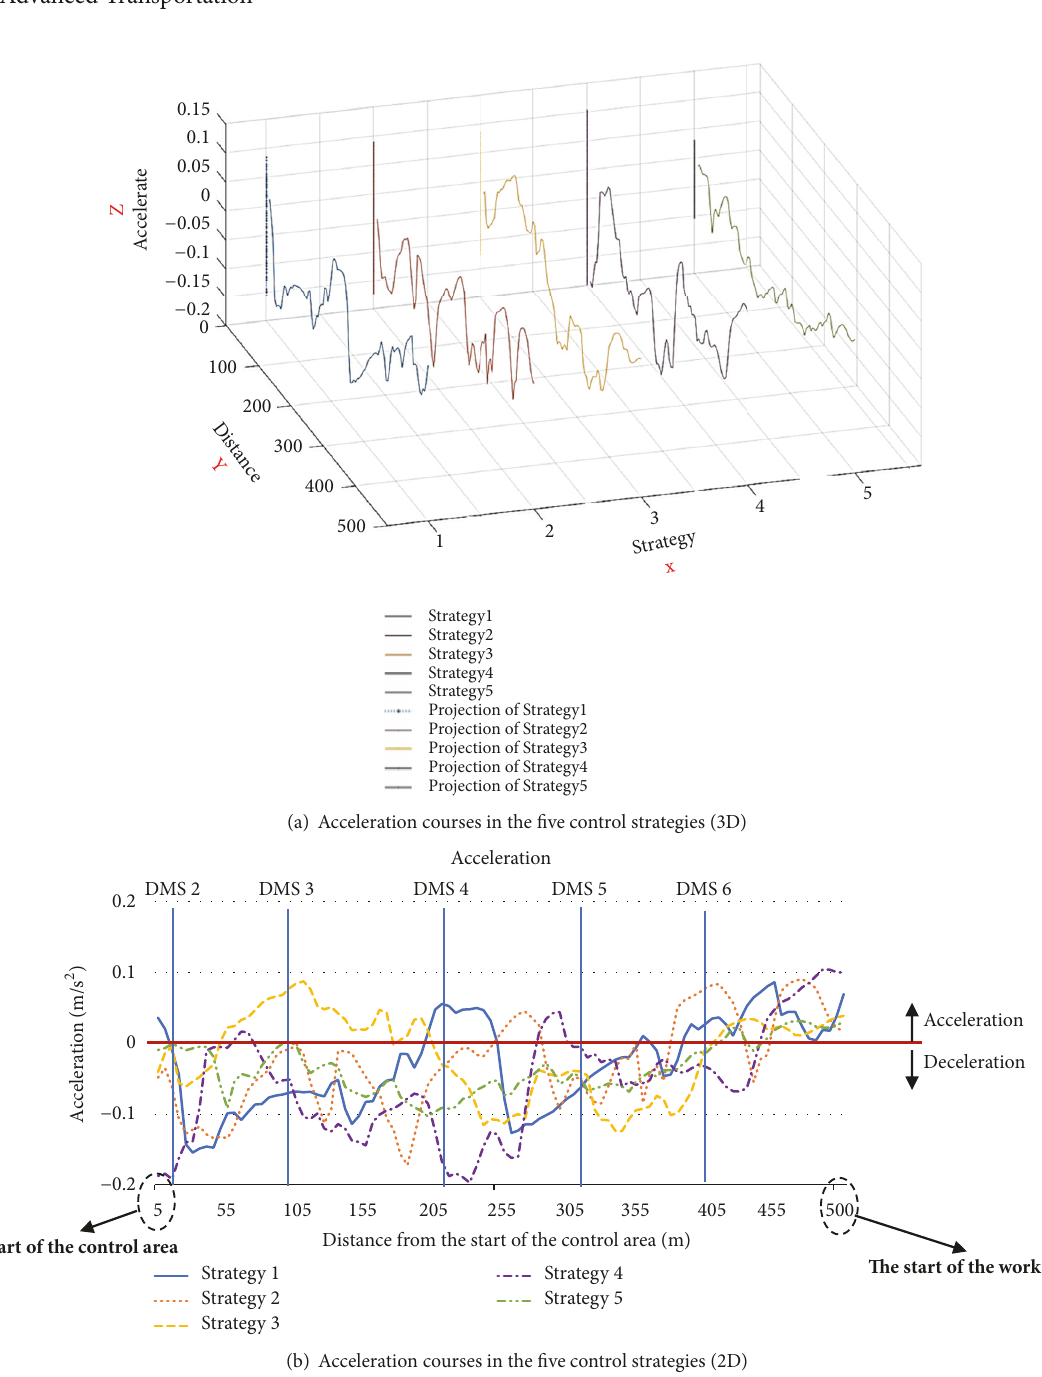
Figure 7: Acceleration courses in the five control